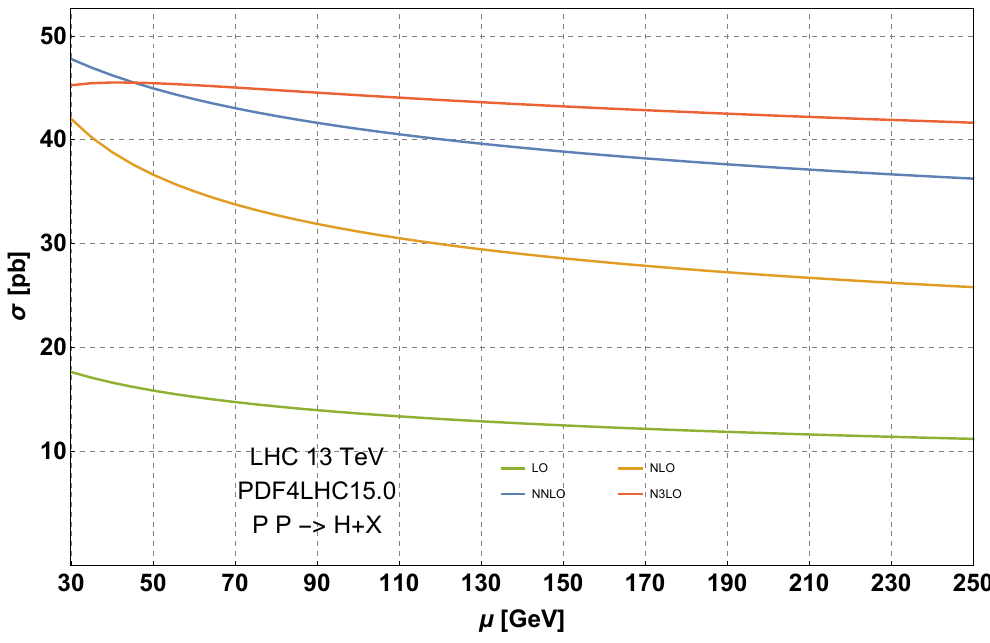
Figure 4 . The (cid:12)gure displays the dependence of the Higgs boson production cross section on the perturbative scale (cid:22) . The green, orange, blue and red lines correspond to a prediction made by truncating the perturbative series at LO, NLO, NNLO and N 3 LO